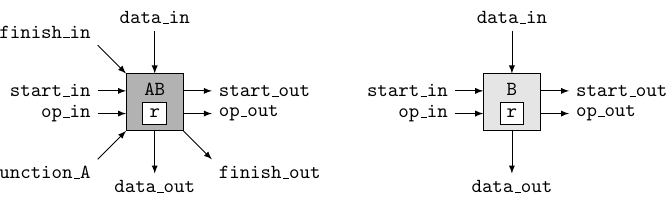
Figure 2: Input and output ports of processor_AB and processor_B from